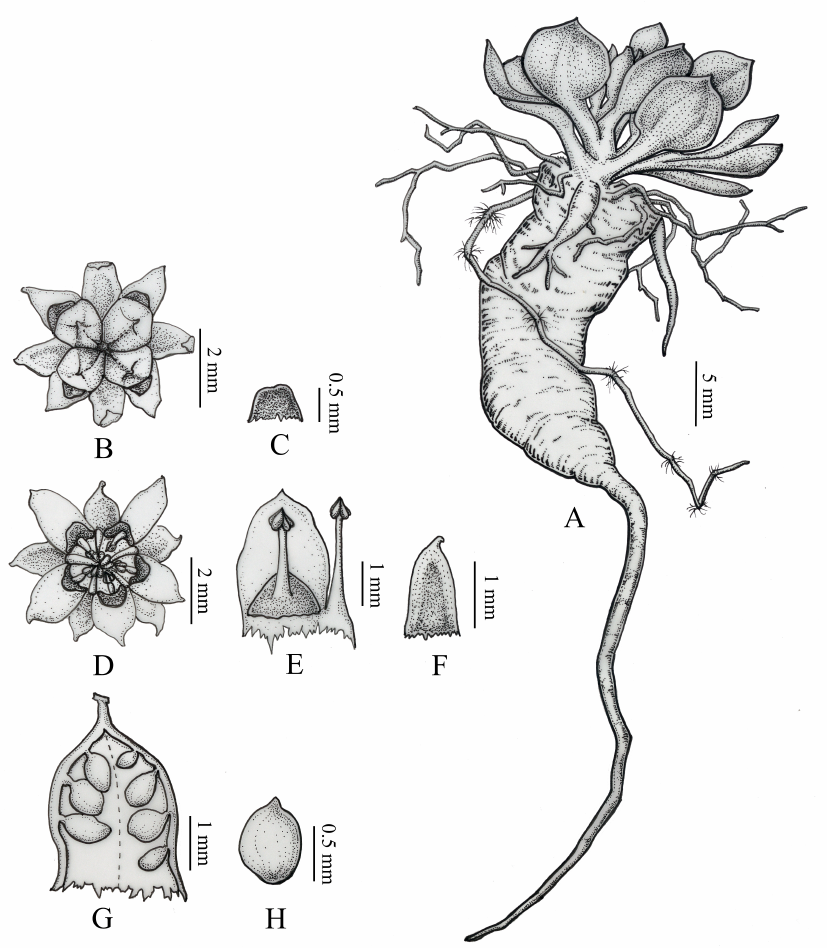
Figure 4. Rhodiola wangii S.Y. Meng. ( A ). Rhizome and flowering stem; ( B ). Female flower; ( C ). Nectar; ( D ). Male flower; ( E ). Petal and Stamens; ( F ). Sepal; ( G ). Follicles; ( H ). Seeds. Drawing by Ye Lv from